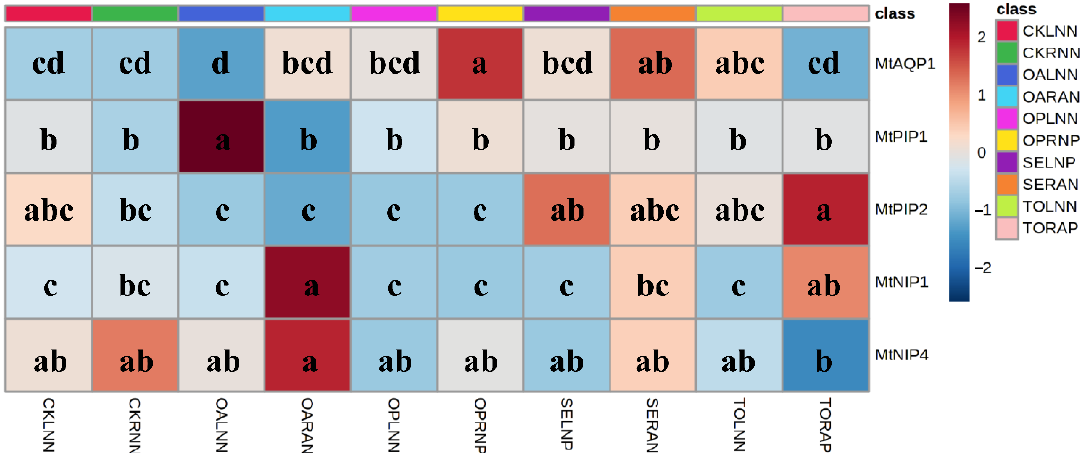
Figure 6. Effects of Pb and R. irregularis inoculation on the expression of MtAQP1 , MtPIP1 , MtPIP2 , MtNIP1, and MtNIP4 in root of M. truncatula . Expression of MtEFα in the root of M. truncatula was used for normalization. Different letters within each gene indicate significant differences by LSD test ( p < 0.05), respectively. The abbreviations are consistent with Figure 1.